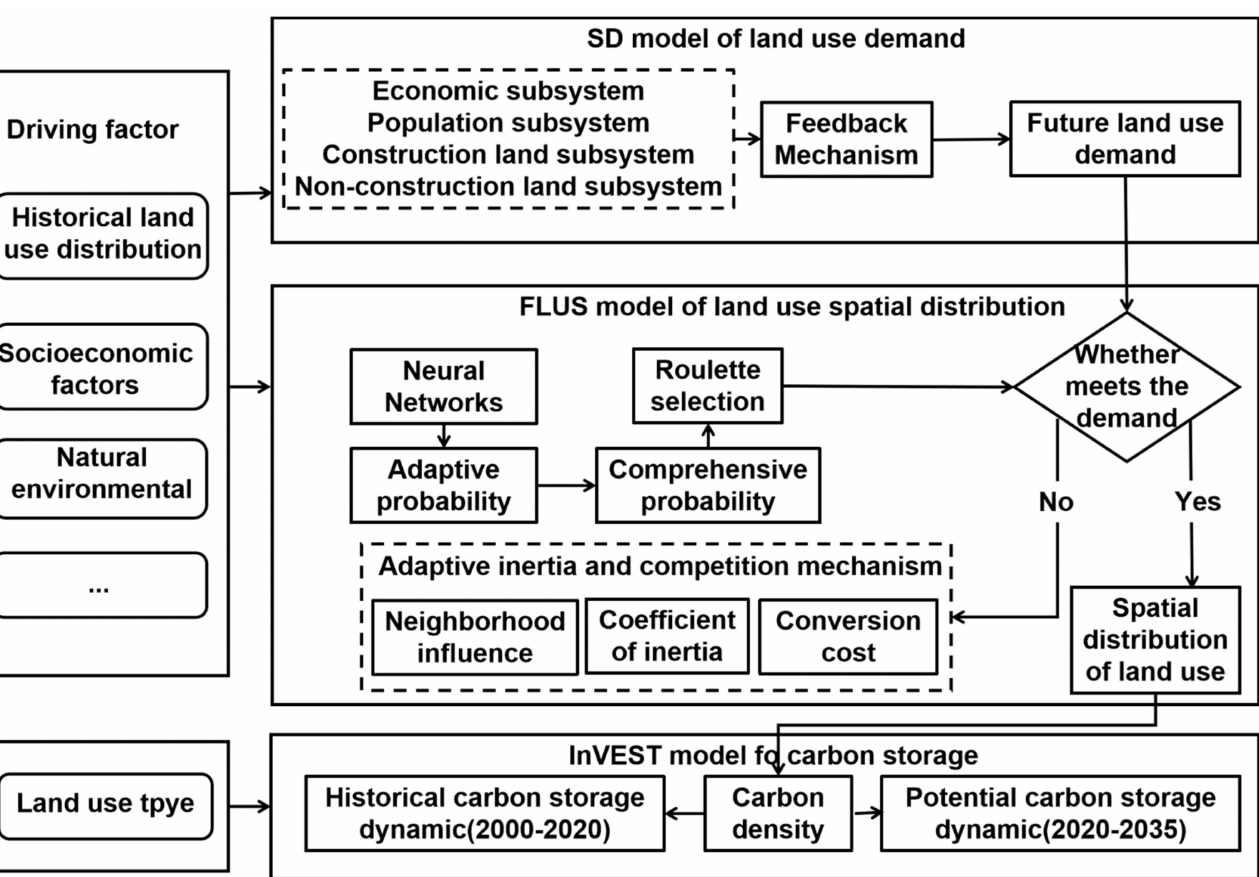
Figure 2. The hierarchical analysis